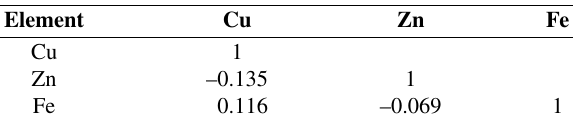
Table 9. Correlation concentration coefficient for Zn, Fe and Cu in human milk samples Element